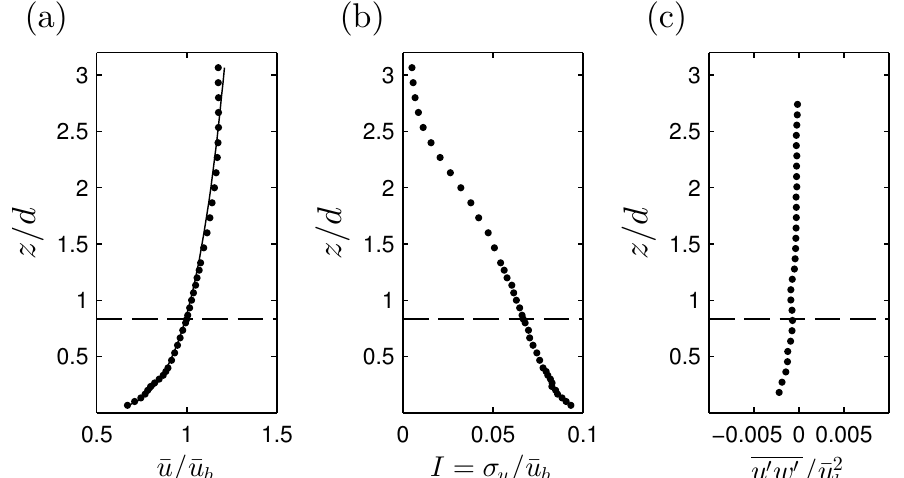
Figure 2. Characteristics of the incoming boundary layer: ( a ) normalized mean velocity and ( b ) turbulence intensity, obtained with a single hot-wire anemometer. The dashed and solid lines represent the turbine axis and fitted power-law curve, respectively. ( c ) Normalized vertical turbulent momentum flux, obtained with a stereo particle image-velocimetry (S-PIV)